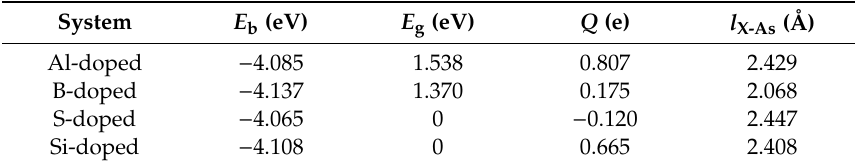
Table 1. The binding energy ( E b ), energy gap ( E g ), Mulliken population ( Q ) and the bond length of X-As ( l X-As ). A positive Q value means the electrons move from the dopant to the substrate. X denotes the dopant